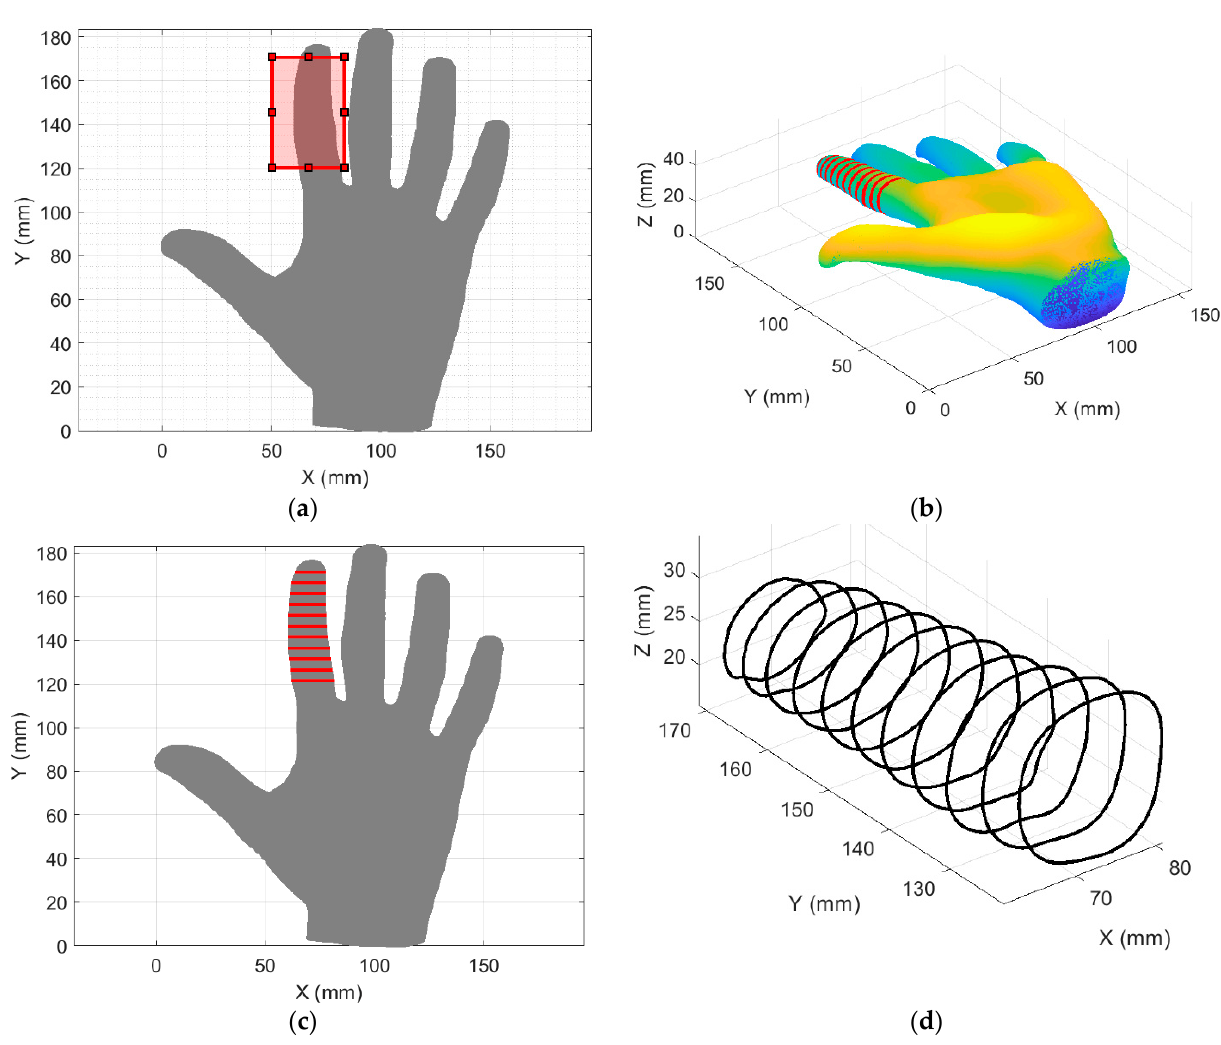
Figure 5. Forefinger boundaries: ( a ) 2D view of the hand (this view allows us to see the palm of the hand) where the zone of interest on the forefinger is pointed out within a rectangle; ( b ) A 3D view of cross sections (red circles) generated for the forefinger; ( c ) A 2D view (XY) of cross sections (red circles) generated for the forefinger; ( d ) Boundaries from cross sections generated for the forefinger.